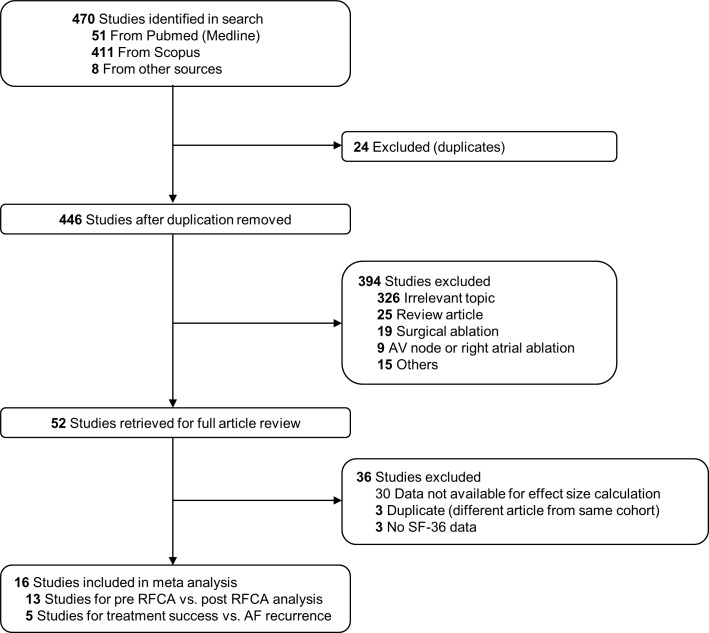
Study selection process.The flow diagram is depicted in accordance with the Preferred Reporting Items for Systematic reviews and Meta-Analyses guidelines. AF: atrial fibrillation; SF-36: short form-36; RFCA: radiofrequency catheter ablation.